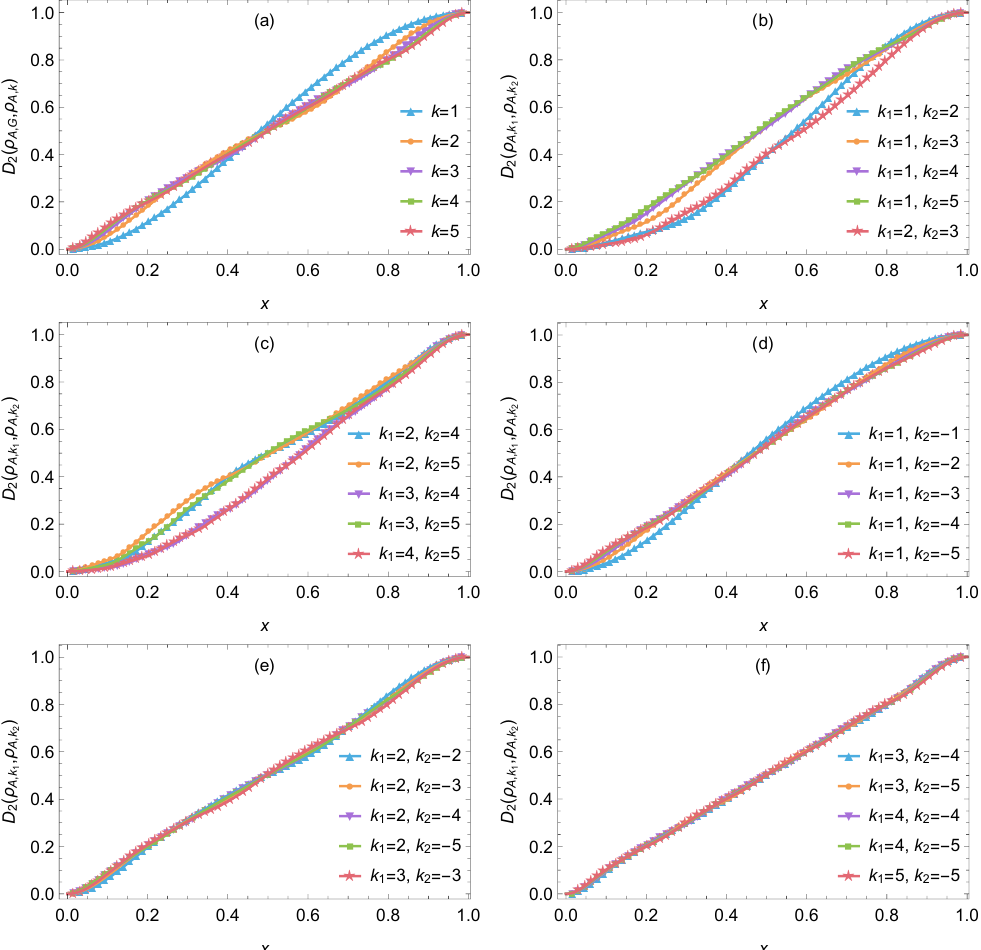
Figure 4 . The second Schatten distances between the ground and excited states in the massless limit of the harmonic chain (symbols) and the 2D free massless bosonic theory (lines). There are perfect matches of the numerical lattice and analytical CFT results (5.9). We have set m = 10 − 5 , L = 64